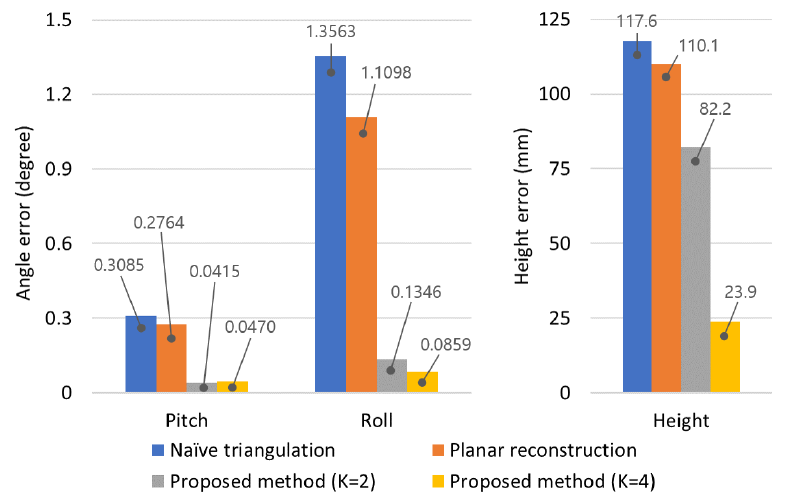
Figure 6. Calibration errors in real calibration